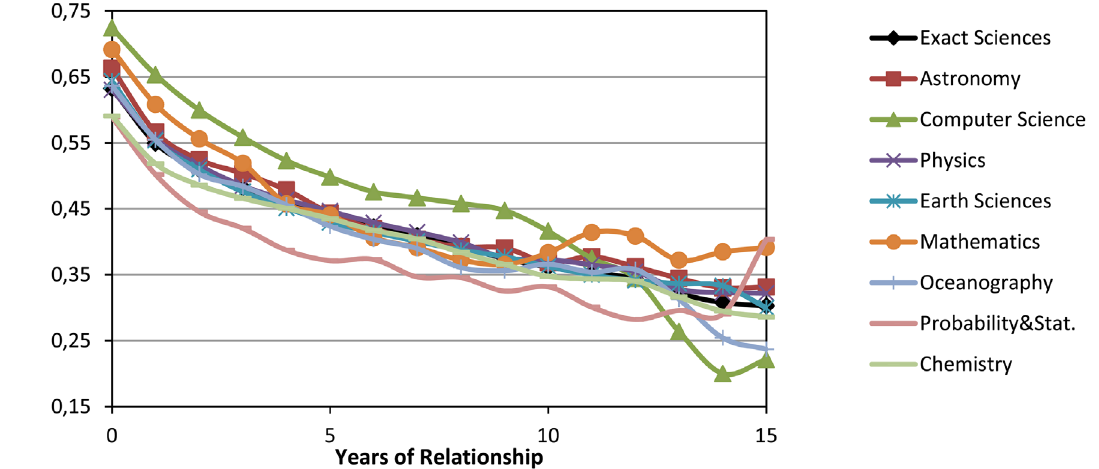
Fig 5. Mean of the Kulczynski index for Exact Sciences and all the